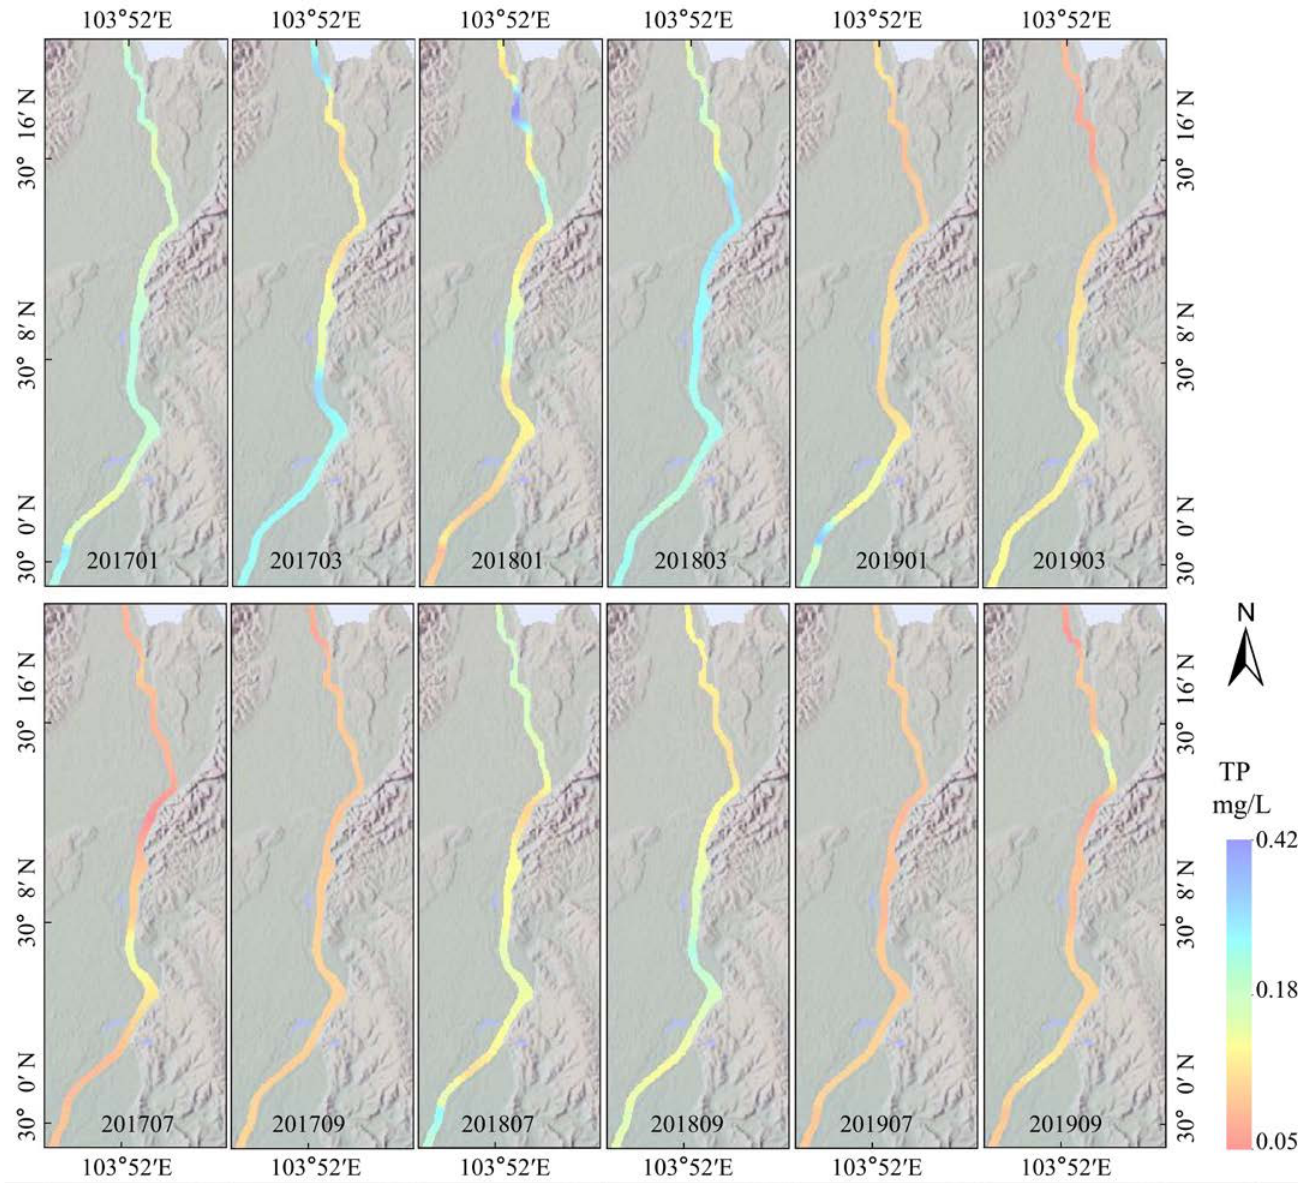
Figure 5. Spatial distribution of TP concentration.